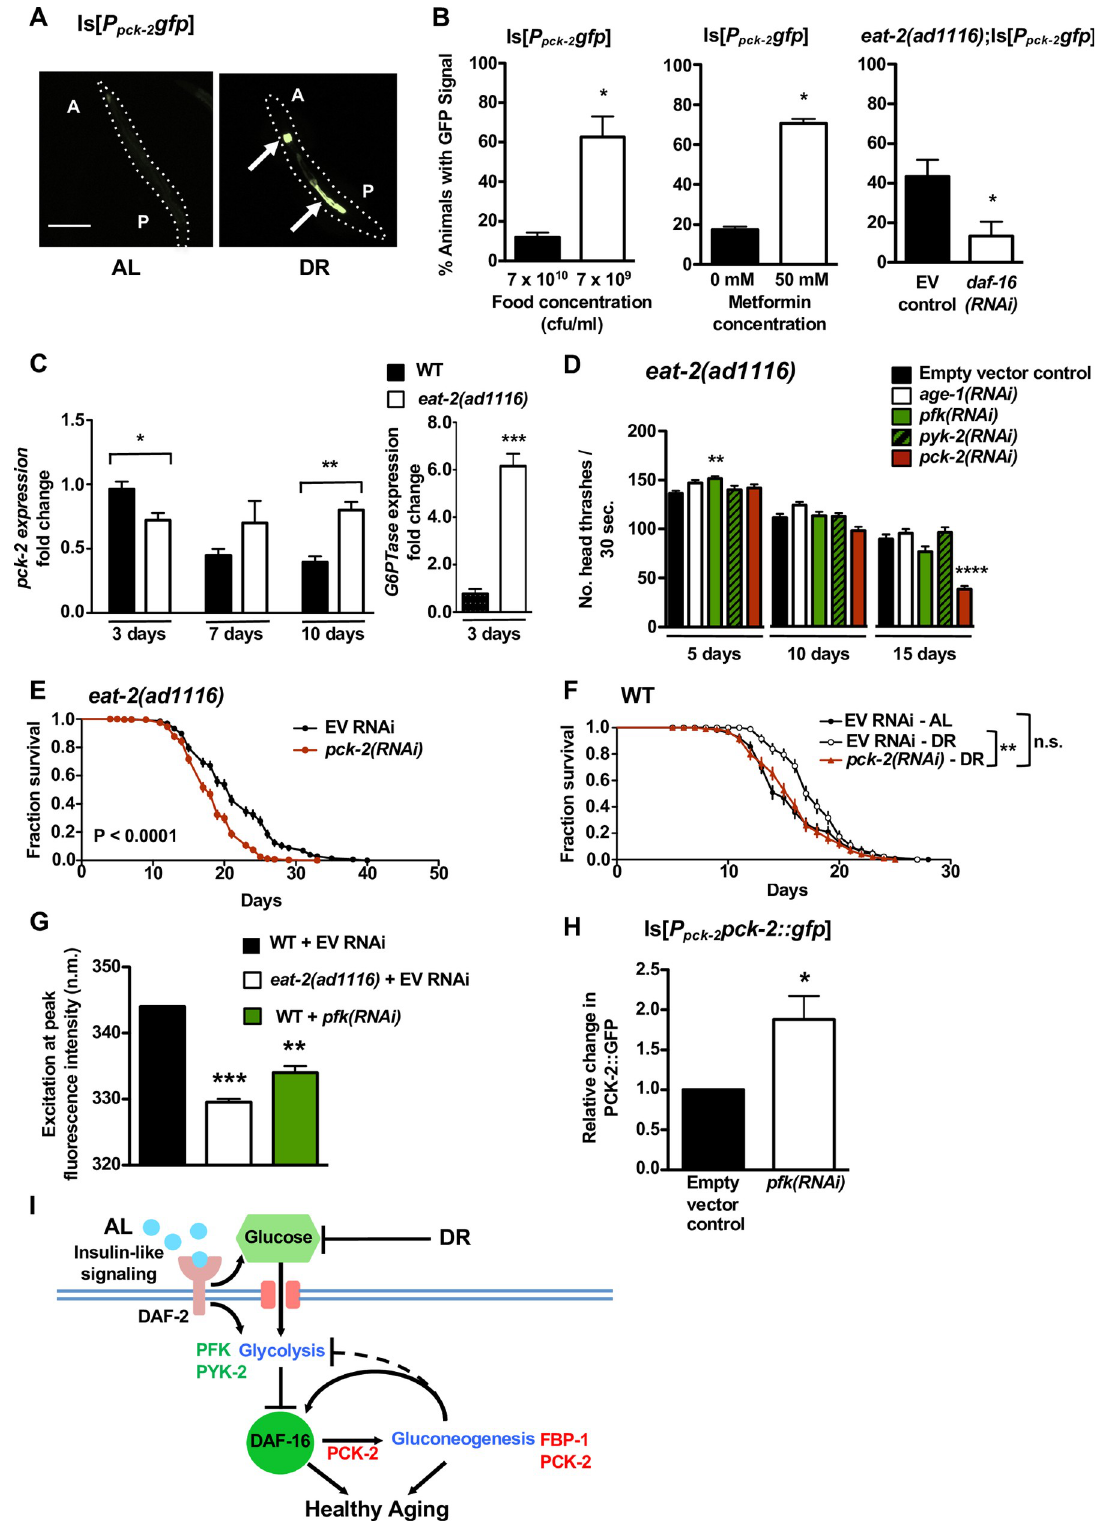
Fig 4. Dietary Restriction Induces Gluconeogenic Gene pck-2 Expression via DAF-16, and pck-2 Expression is Needed for DR- associated Healthspan Benefits. (A) Representative wild-type animals expressing a GFP transcriptional reporter for pck-2 (